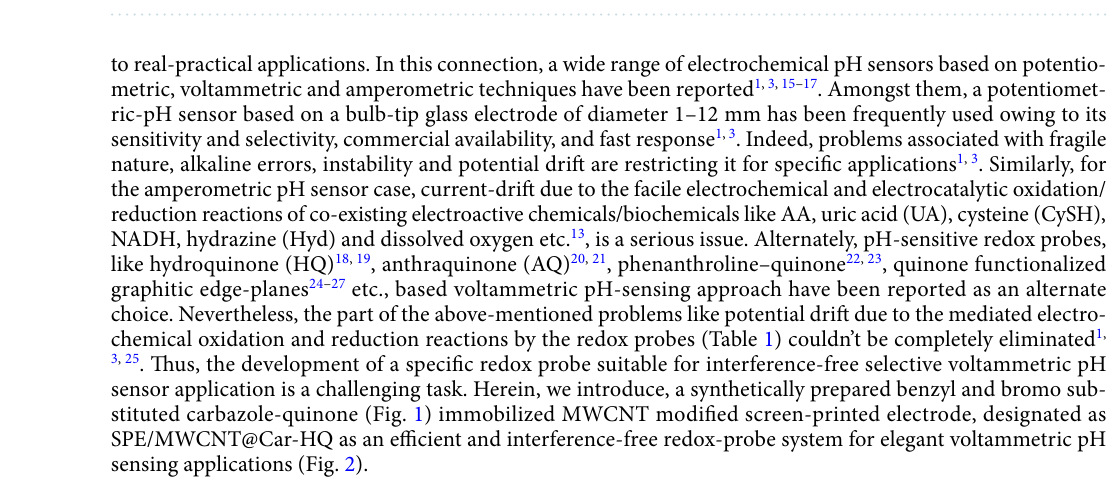
Figure 1. Synthesis route adopted to prepare 9-benzyl-3-bromo-1 H -carbazole-1,4(9 H )-dione (Car-HQ)